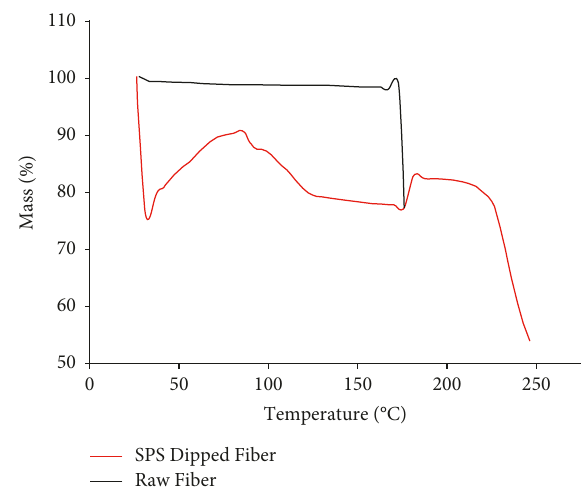
Figure 5: TGA of raw and SPS-dipped PP fiber.